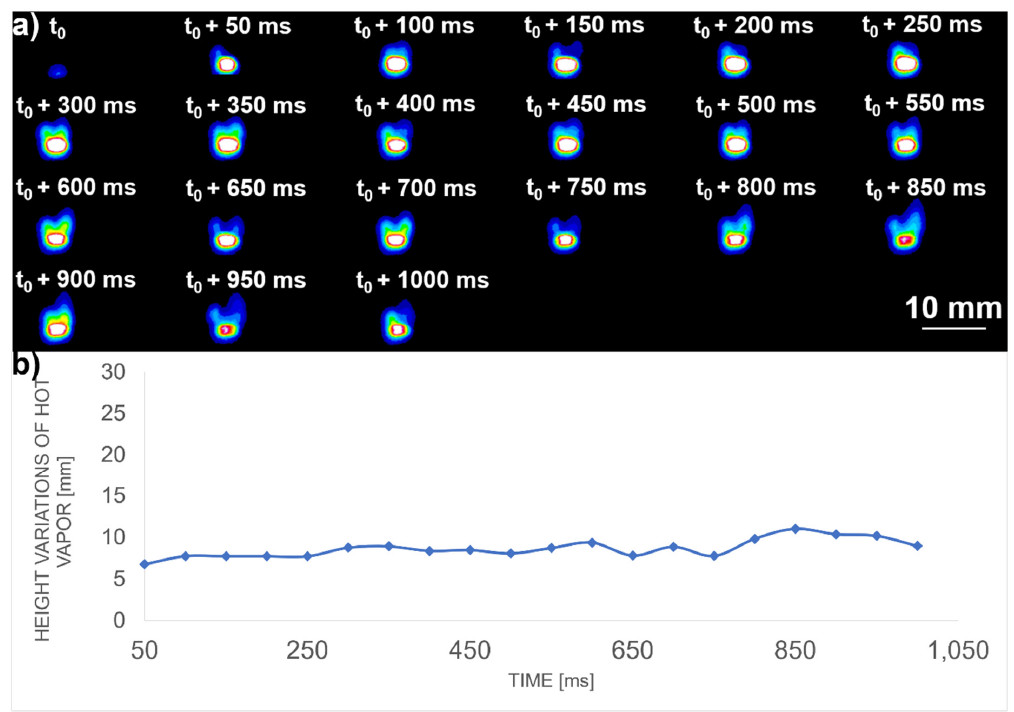
Figure 6. Hot vapor plume height variation during laser welding of AlMg3 alloy: ( a ) images highlighted in false colors and ( b ) plot of the plumes values.